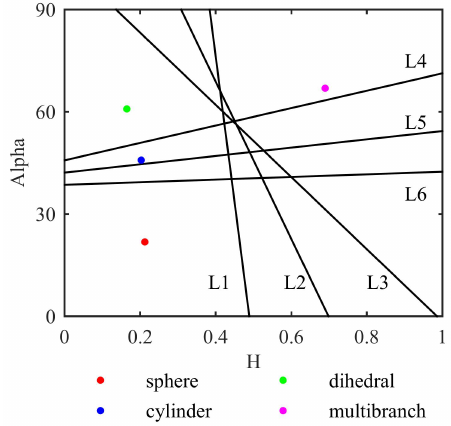
Figure 13. All boundary lines.